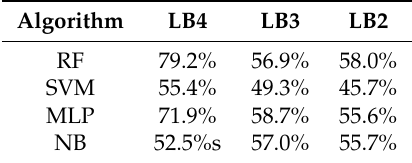
Table 2. Accuracy for Raw sample